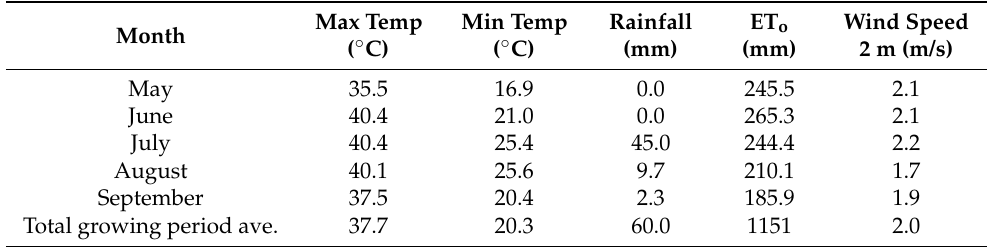
Total growing period